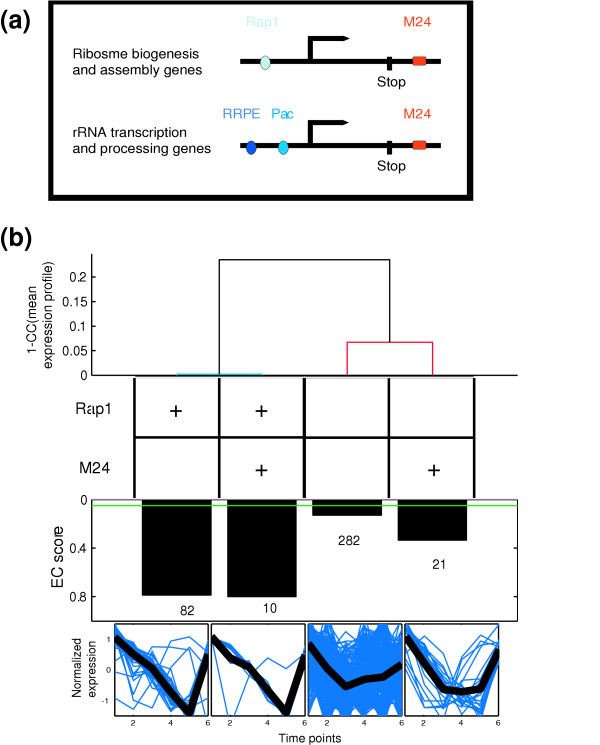
A combined regulation of protein biosynthesis genes by promoter and 3' UTR motifs. (a) A schematic depiction of the regulation of typical ribosomal biogenesis and assembly genes and of rRNA transcription and processing genes. While many protein biosynthesis genes (predominantly ribosomal genes) are regulated by Rap1 in their promoters, and most rRNA transcription and processing genes are regulated by the combined Pac-RRPE cassette, these two types of genes are suggested here to share a stability-associated motif in their 3' UTR, namely M24. (b) Combinogram analysis [18] of the protein biosynthesis genes in the condition of environmental response to peroxide stress [61]. We gathered all genes annotated with protein biosynthesis by the SGD [32] and partitioned them into four disjoint sets: genes containing only RAP1, only M24, both of them and neither of them. The motif presence is marked by a plus symbol in the second panel. The first panel presents a dendrogram built using the correlation coefficients between the mean expression profiles of each of the four sets. We also present, for each set, its EC score [18,31], in a bar diagram. All four EC scores had a p-value < 0.05. The number of genes in each set is also given, for which we had expression profiles in the presented condition. Finally, in the fourth panel, we show the expression profiles of the genes in each set in blue, and their mean profile in black. The genes on the far right of the fourth panel, which contain only M24 in their 3' UTRs, but not Rap1 in their promoter, exhibit a significantly more coherent behavior than the background set (genes containing neither of the two motifs) and their profiles show a sharper decrease in the beginning of the experiment.